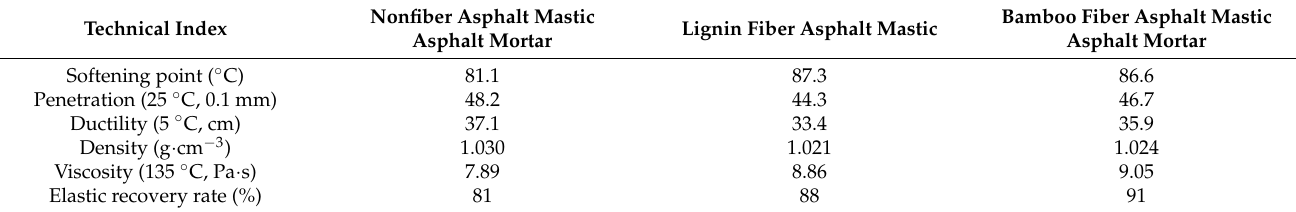
Table 7. Test results of physical properties of each fiber asphalt mastic.